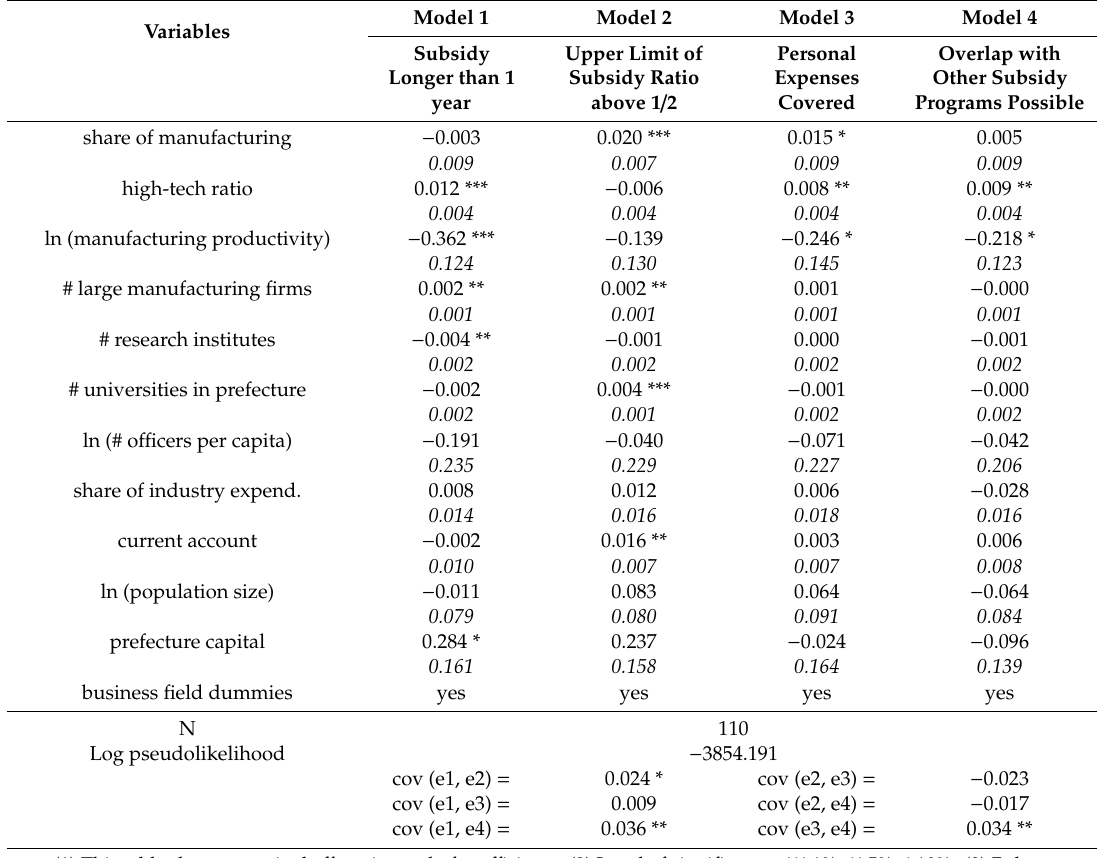
Table 8. Structural estimation modeling.